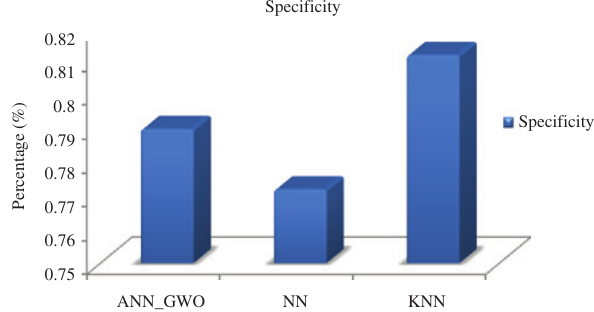
Figure 6: Specificity Comparison for Different Classifiers.